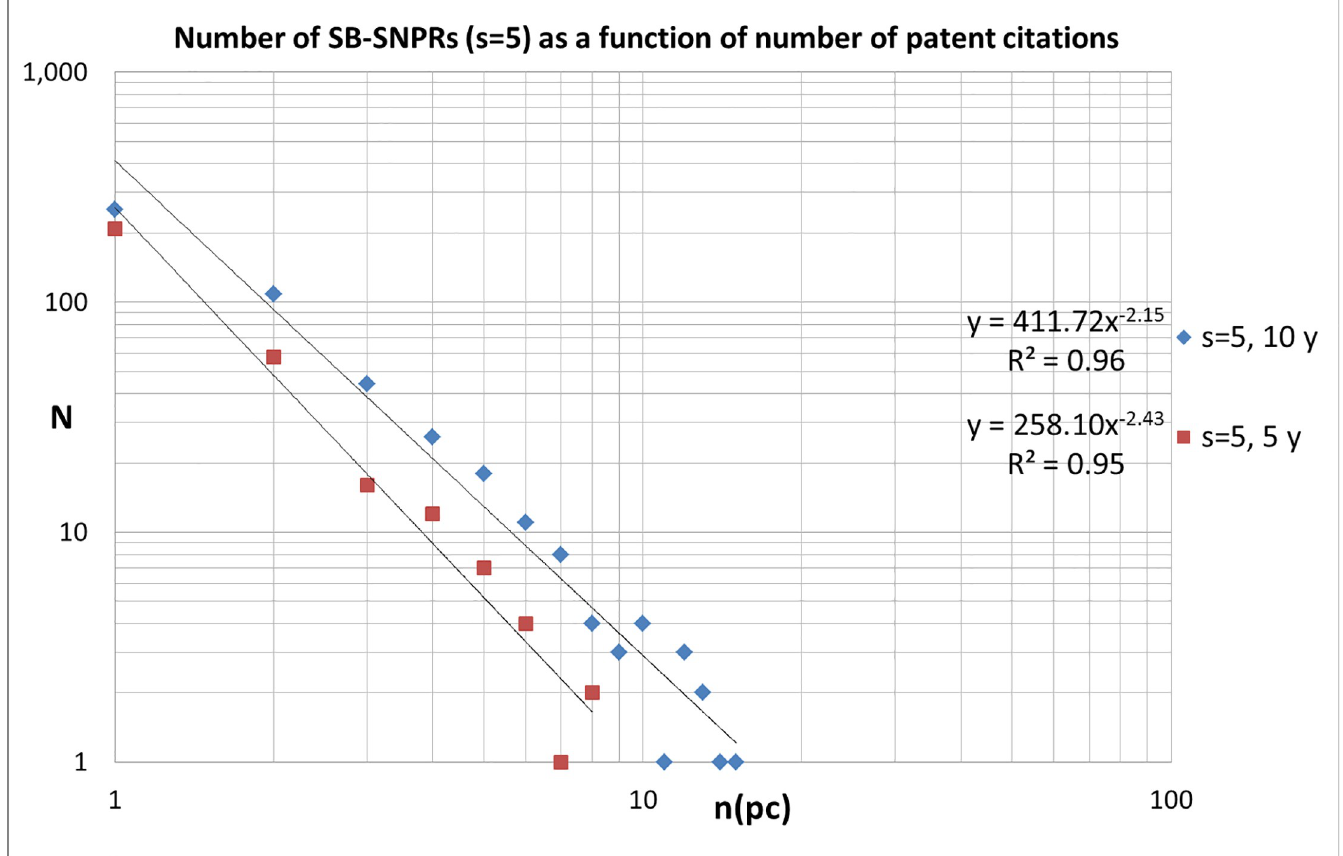
Fig 12. Number of SBs with s = 5 cited by patents as a function of number of patent citations n(pc), citation windows 5 and 10 year.